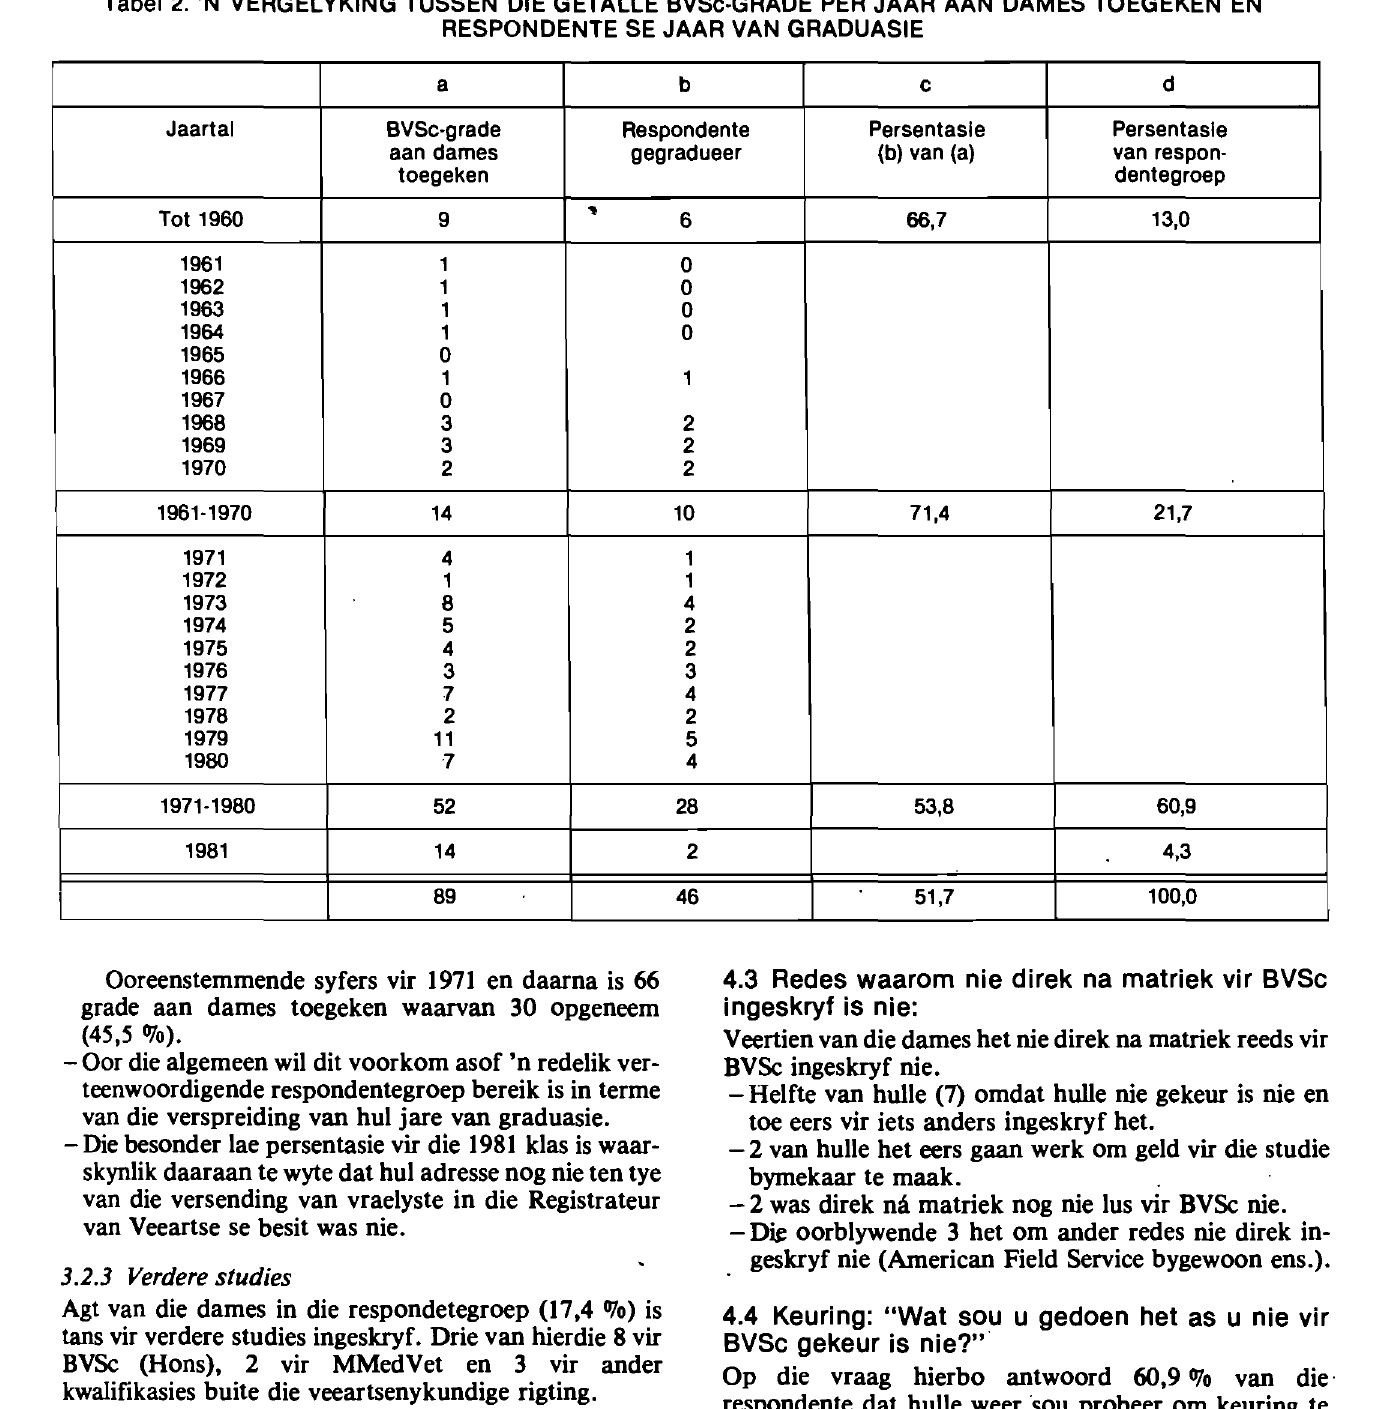
Tabel 2. 'N VERGELYKING TUSSEN DIE GETALLE BVSc-GRADE PER JAAR AAN DAMES TOEGEKEN